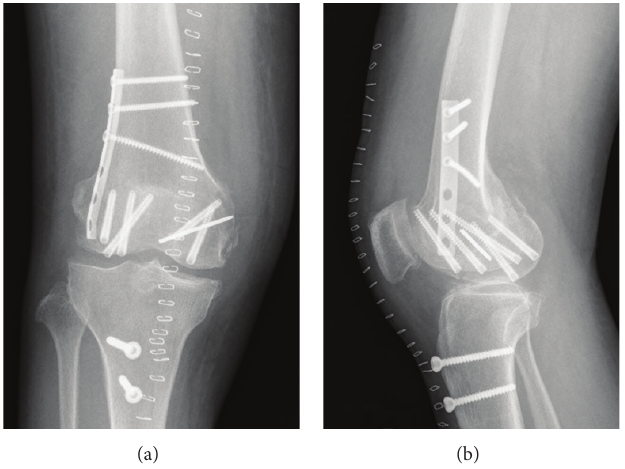
Figure 4: Anteroposterior (a) and lateral (b) radiographs obtained right after surgery.